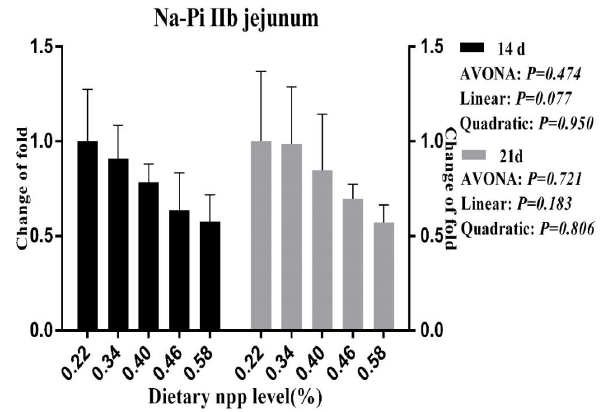
Figure 2. Effect of dietary non-phytate phosphorous levels on NaPi-IIb gene expression in jejunum of ducks at 14 d and 21 d of age. NaPi-IIb, type IIb sodium-phosphate cotransporter; npp, non-phytate phosphorous.